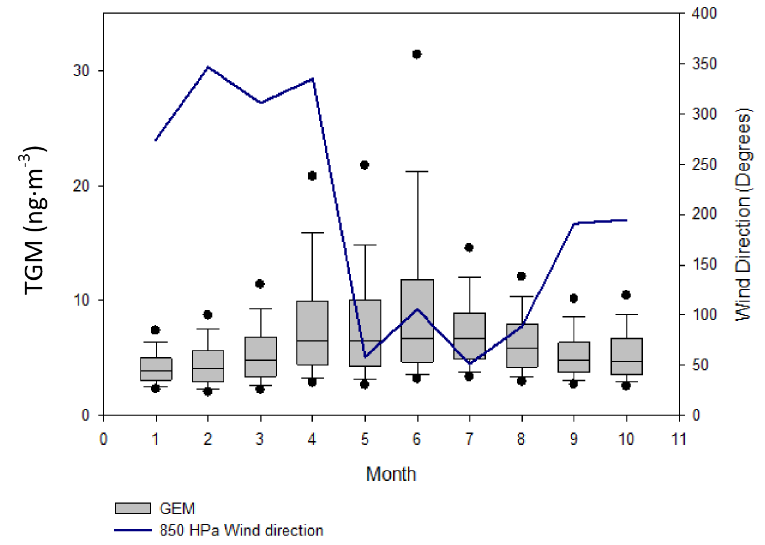
Figure 7. Box plot of TGM concentrations over each month with the center of each box being the median, the box bottom and top the 25th and 75th percentiles respectively, the extended lines the 10th and 90th percentile values, and the points the 5th and 95th percentile values. Wind direction (blue solid line) is based on monthly averages at the 850 hPa level from